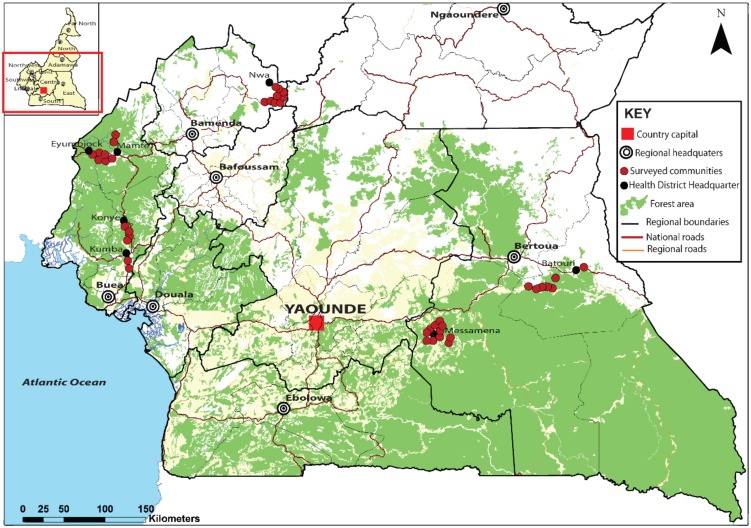
Map of the study area.